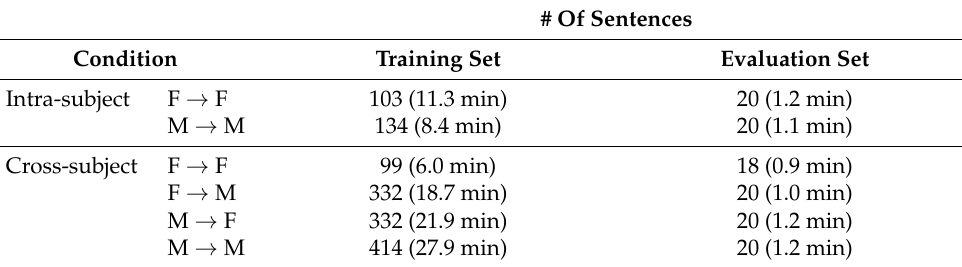
Table 1. Details of dataset used for